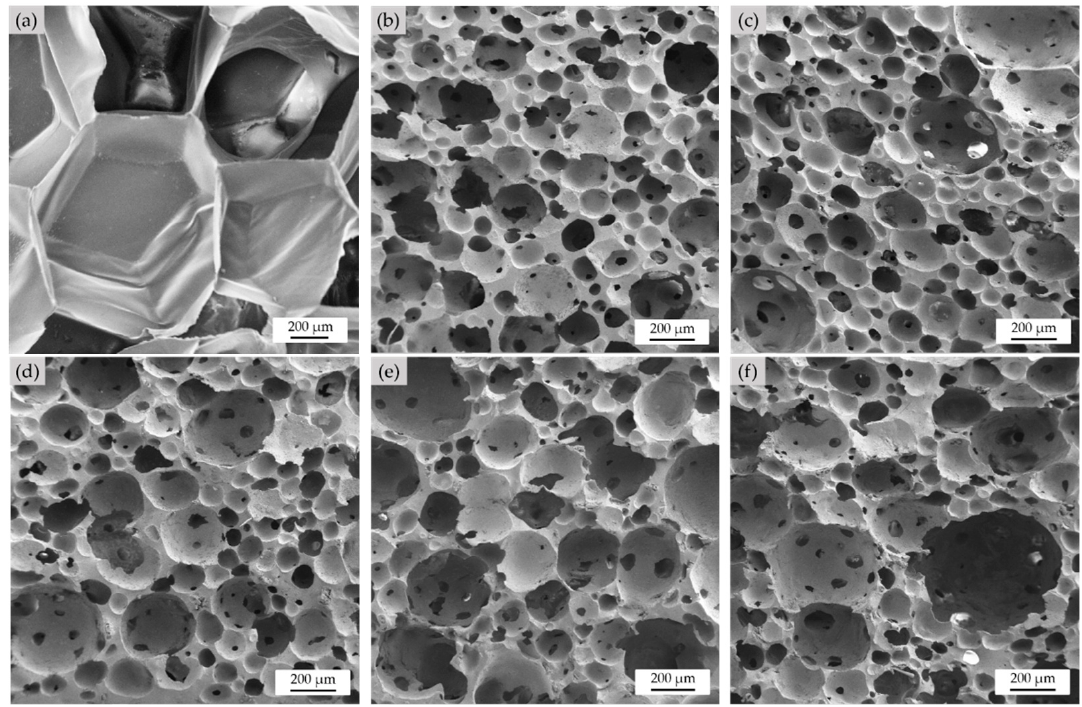
Figure 8. Cushion foams morphology at a 50 × magnification: ( a ) EPE-FN; ( b ) NRL-FN-BLF0.0; ( c ) NRL-FN-BLF2.5; ( d ) NRL-FN-BLF5.0; ( e ) NRL-FN-BLF7.5; ( f ) NRL-FN-BLF10.0.